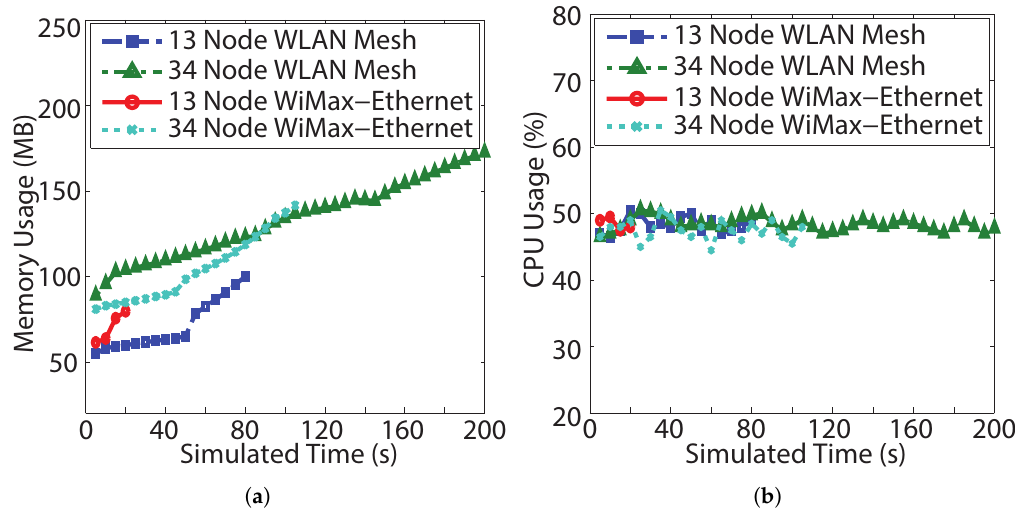
Figure 14. The usage of memory and cpu of simulation scenarios. ( a ) Memory usage; ( b ) CPU usage.